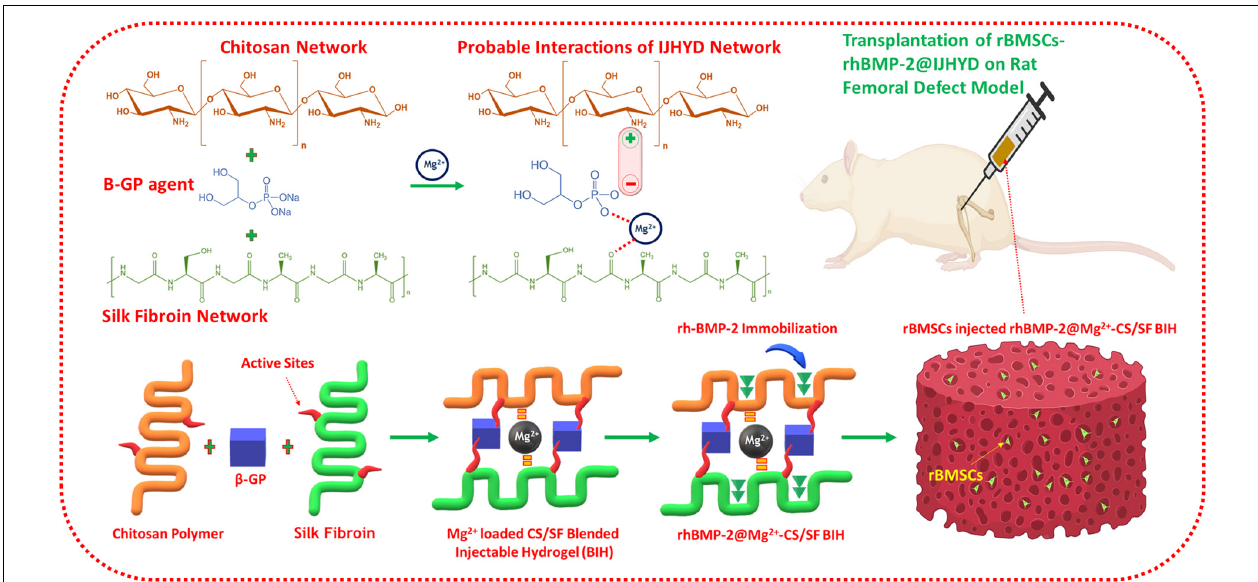
FIGURE 1 | Schematic representation of magnesium (Mg) loaded chitosan (CS)/silk fibroin (SF) blended injectable hydrogel formation with probable mechanisms according to the present investigation.